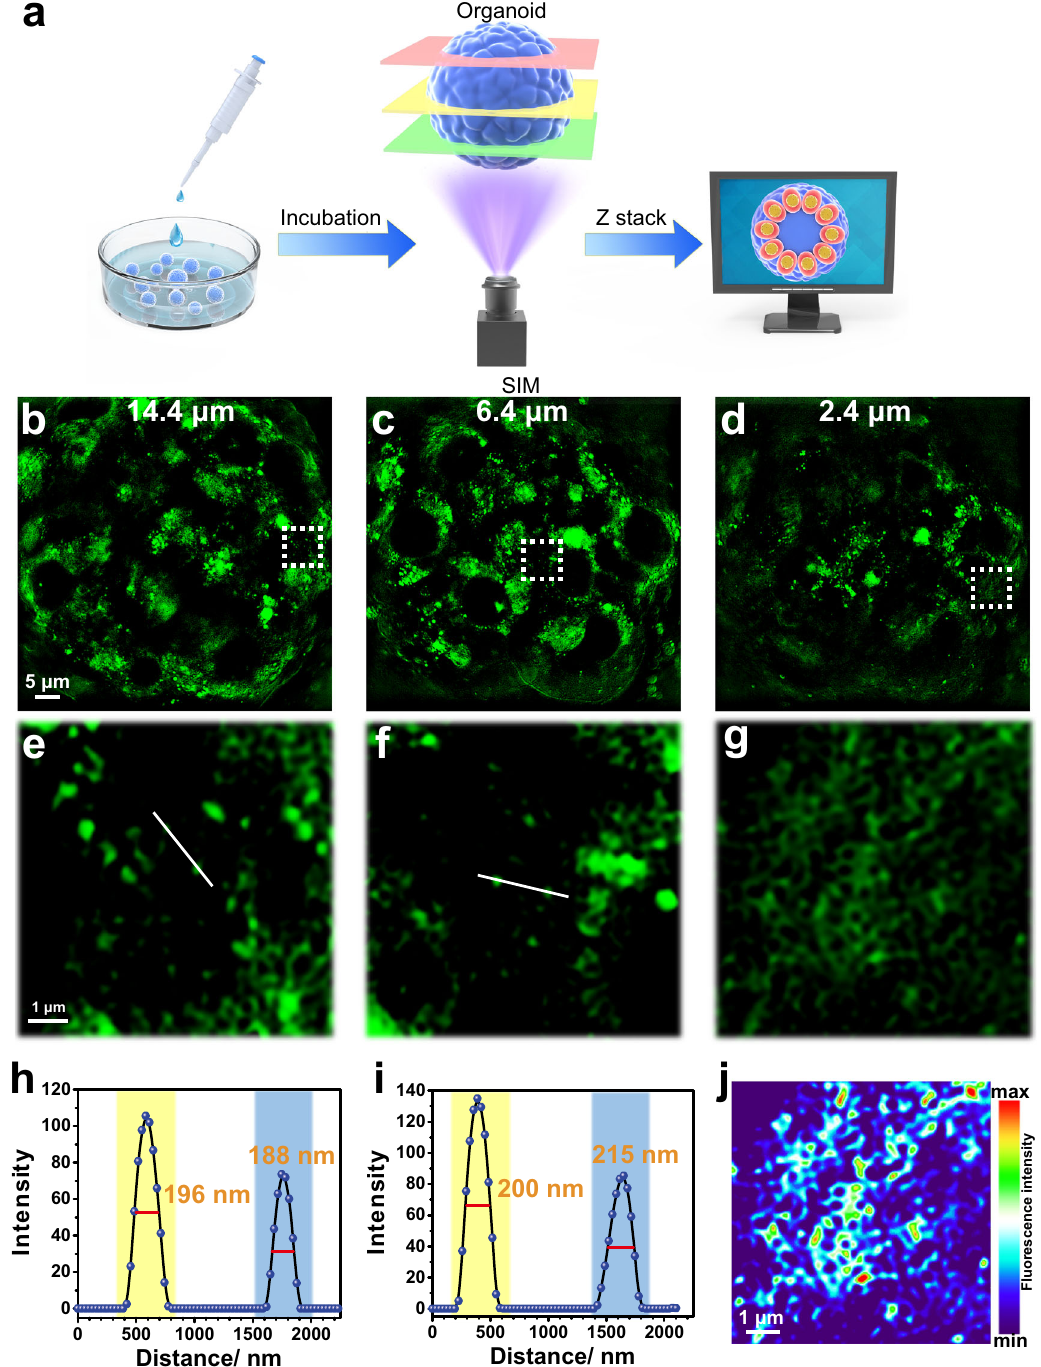
Fig. 8 NapBu-BPEA can identify organelles in liver organoids. SIM imaging of organoids treated with CCCP for 24 h. a Schematic diagram of Z-stack SIM imaging for organoid; b – d SIM images of organoids recorded at different imaging depths; e – g enlarged images for the regions of interest showed in the frames in b – d ; h , i fl uorescence intensity pro fi les along the white lines in e , f ; j fl uorescence intensity thermal image of g constructed with ImageJ. Scale bar: 5 μ m, enlarged images scale bar: 1 μ and Horiba FM-4 fl uorophotometer. The cell imaging was carried out by Nikon N-SIM system.